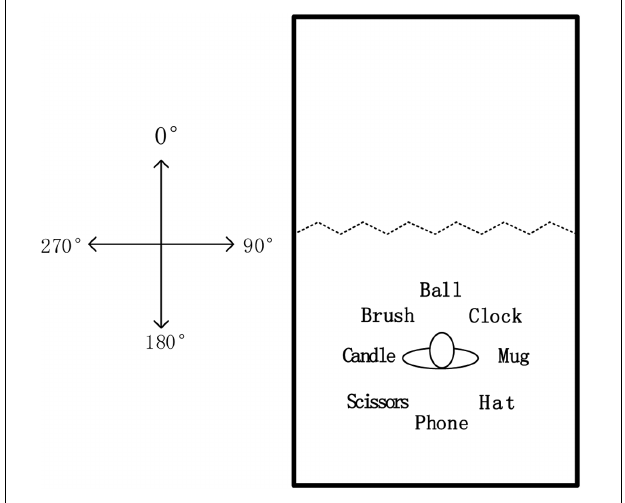
FIGURE 1 | The map of object arrays in the test room for this